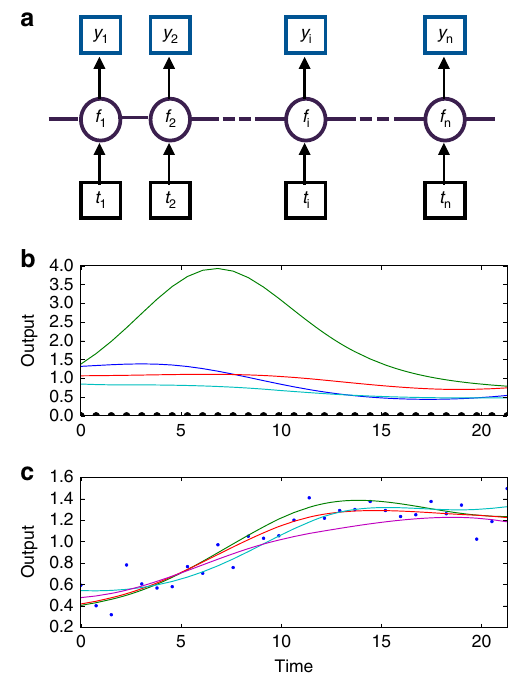
Figure 1 | An overview of inference with Gaussian processes. ( a ) A graphical model of a Gaussian process 6 . Squares denote known variables (times, t i , and data points, y i ); circles denote unknown variables (the underlying, latent function, f i ). We associate a variable in the Gaussian process to each time point and the value of this variable gives the value of the latent function. Each observed data point, y i , depends only on the corresponding latent variable, f i . Each f variable, however, depends on all the other f variables (they covary). ( b ) Four examples of latent functions with a squared exponential covariance function. The functions are strictly only defined at the time points of the observations (shown with black semi- circles on the x axis) but are drawn with a continuous line for clarity. ( c ) Four examples of latent functions after conditioning on the data (data are shown as blue dots). Although each individual function is smooth, there is more variation between functions where the data is more spread. Averaging many latent functions gives the best fit. The hyperparameters of the covariance matrix are the same as those in b